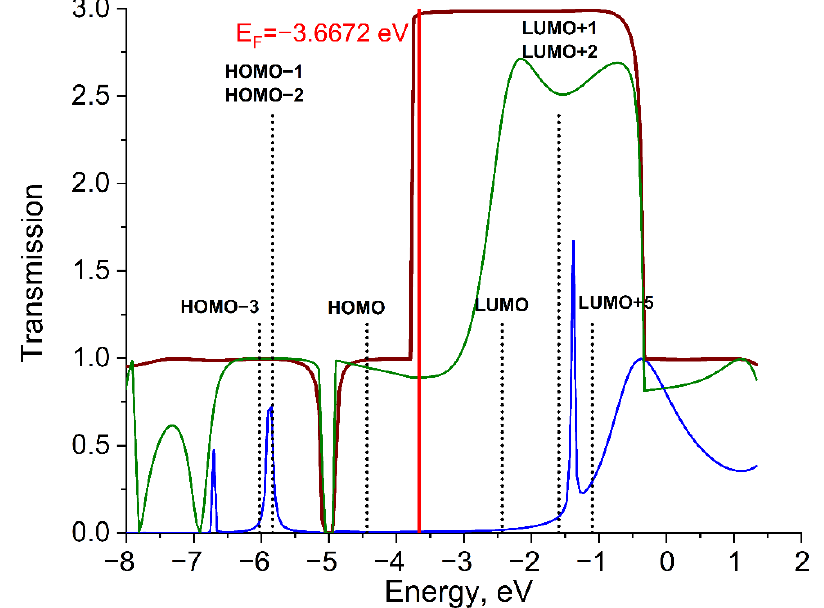
Figure 4. Transmission functions T DMT (E) (green for d(Al-Mo) = 2.70 Å and blue for d(Al-Mo) = 4.30 Å) for the Al 6 – DMT – Al 6 system and transmission function T wire (E) (brown) for the Al 6 -Al 6 system. E F denotes the Fermi level of electrodes. Energy positions of bonding ( σ , π , δ ) and antibonding ( σ *, π *, δ *) MOs are shown by vertical lines (black dots).